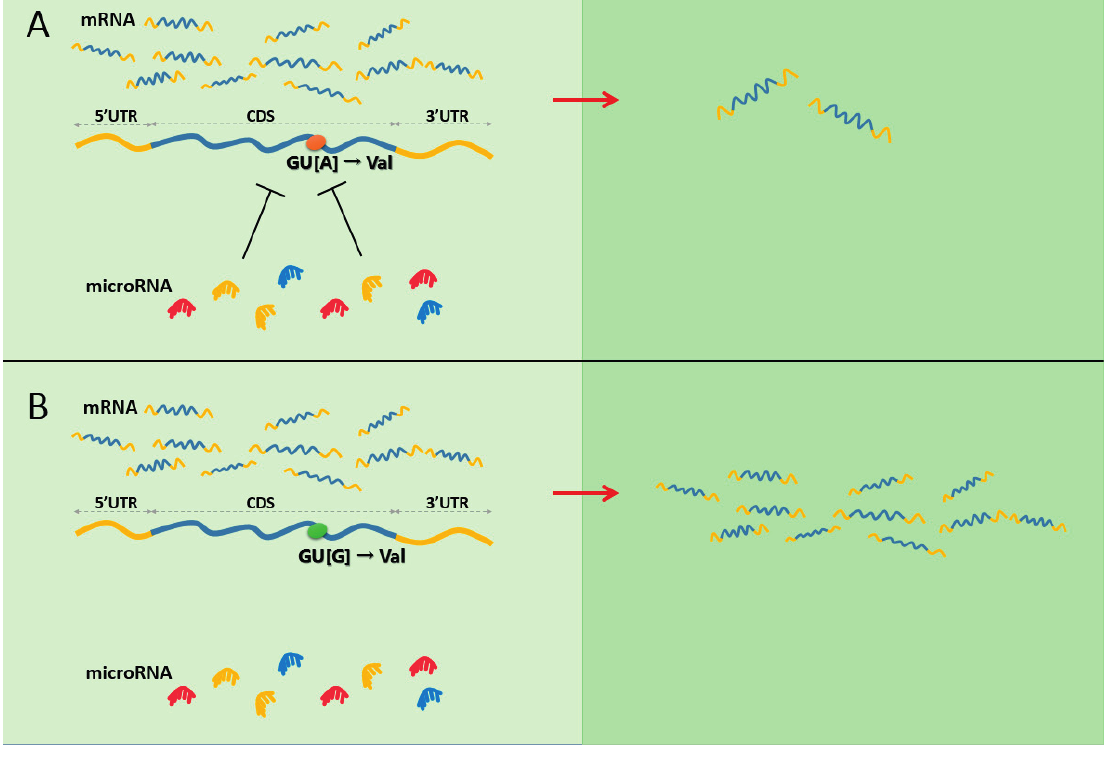
Figure 1. The model for the mechanism that synonymous SNPs could have functional consequences through aberrant miRNA-mediated gene regulation. ( A ) An “A” mutant (the orange nucleotide) at the synonymous SNPs in one gene makes it possible that the gene is regulated by the given miRNA, which will result in decreased gene product; ( B ) As a comparison, the gene with a “G” mutant (the green nucleotide) cannot be regulated by the given miRNA, which have no effect on gene